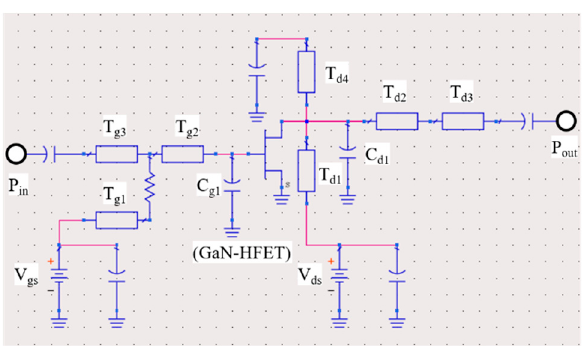
Figure 2. Schematic diagram of the power amplifier.